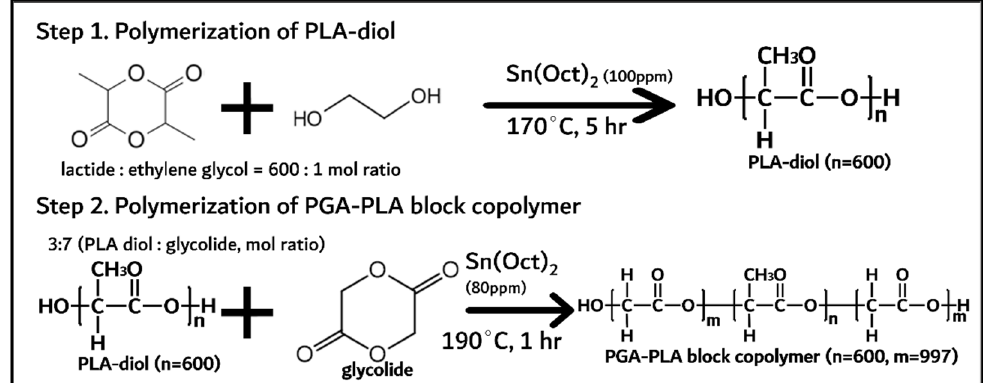
Figure 1. Synthesis of PGA–PLA block copolymer.